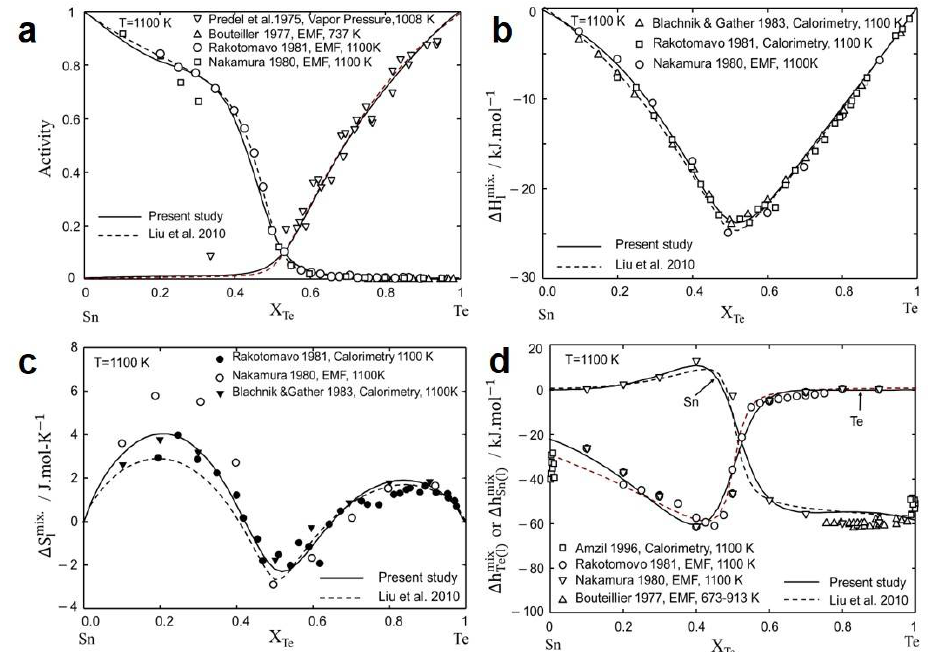
Figure 4. Calculated thermodynamic properties at 1100 K ( a ) activity of Sn (l) and Te (l), ( b ) mixing enthalpy of liquid, ( c ) mixing entropy of liquid, and ( d ) partial enthalpy of Sn (l) and Te (l) in liquid solution along with respective experimental data from [63,64,72–75].